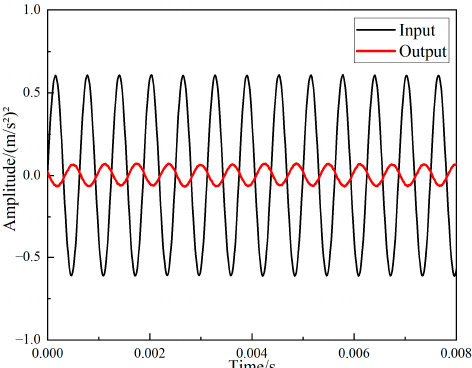
Figure 21. Time domain input and output signal of periodic structure support.